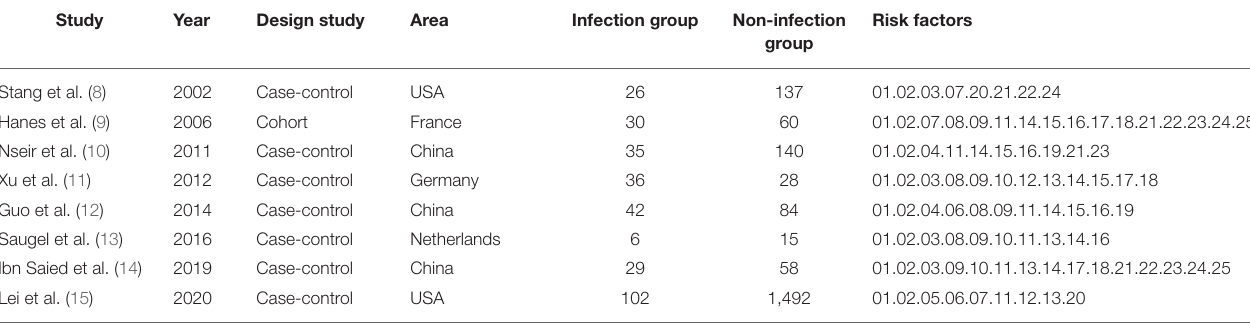
TABLE 1 | Characteristics of the included studies. Study